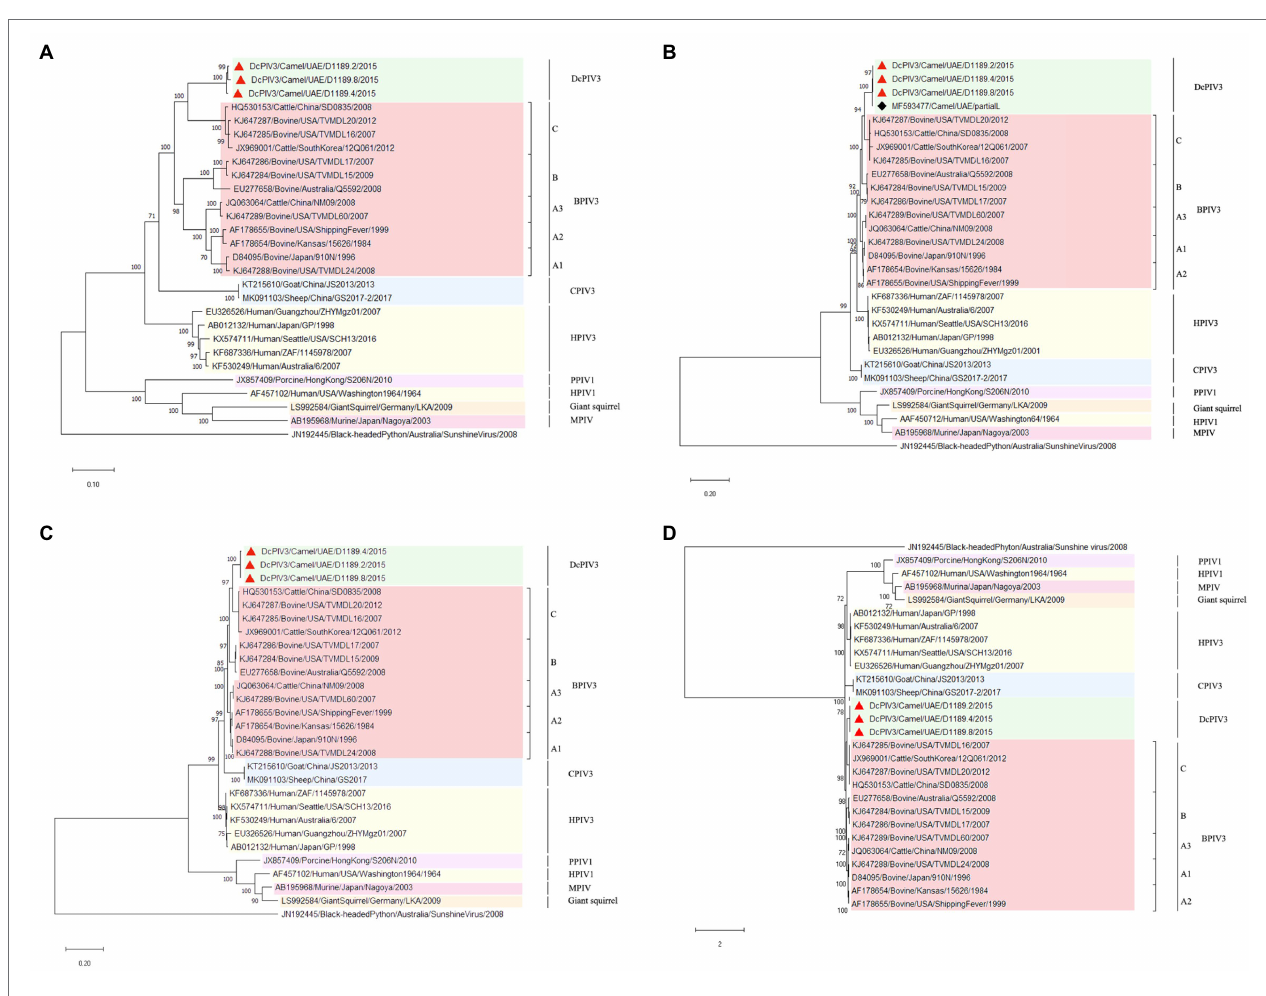
FIGURE 5 | Phylogenetic analyses of (A) the complete genome, the amino acid sequences of (B) partial L protein and (C) complete L protein, and (D) the nucleotide sequences of the complete L gene of the three DcPIV3 strains discovered in the present study. Phylogenetic trees were generated using Jukes and Cantor (JC) model (complete genome), Jones Taylor Thornton (JTT) model (partial L and complete L protein), and General Time Reversible (GTR) + G model (complete L gene) with 1,000 bootstrap pseudoreplicates. Nineteen thousand and fifty-four nucleotide positions of the complete genome, 1,635 and 2,428 amino acid positions of the partial and complete L protein, and 5,861 nucleotide positions of the complete L gene were included, respectively, in the analyses. Trees with the highest log likelihood ( − 181887.15 for the complete genome, − 17365.96 for the partial L protein, − 27636.23 for the complete L protein, and − 53701.29 for the complete L gene) are shown. Bootstrap values are shown next to the branches. The scale bar indicates the number of nucleotide or amino acid substitutions per site. The three DcPIV3 strains sequenced and analyzed in the present study are shown in red triangular and black spade for MF593477. All the accession numbers are given as cited in